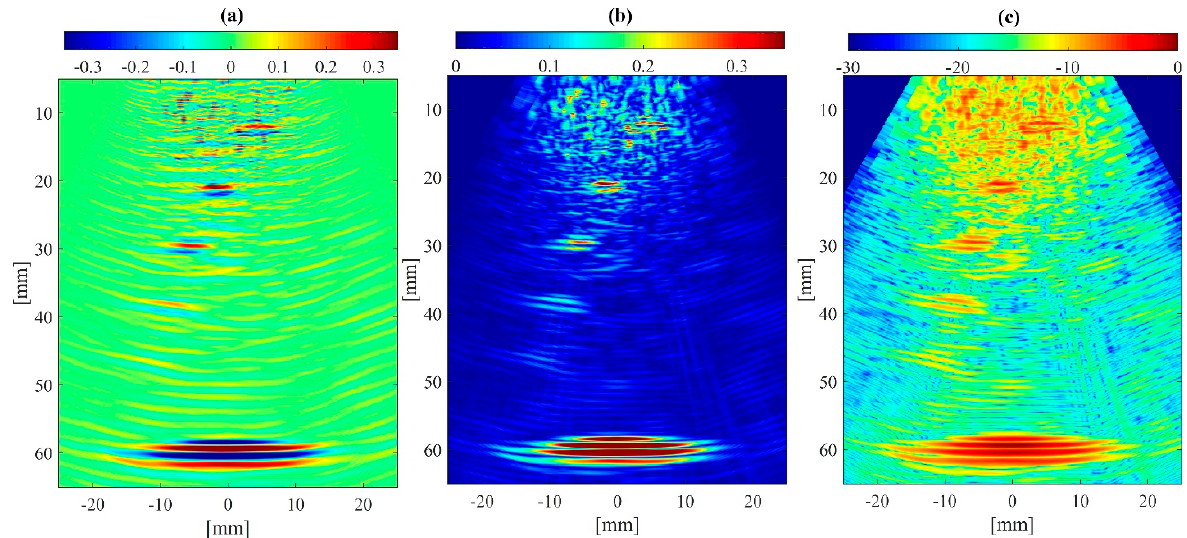
Figure 11. TFM image of the CFRP sample, but, this time, obtained employing array transducers with a central frequency of 4 MHz while the central frequency of the chirp signal was 2.50 MHz. The image is reconstructed based on the ( a ) the full-wave amplitude, ( b ) the energy, and ( c ) energy in the dB scale of the UT echo signals.